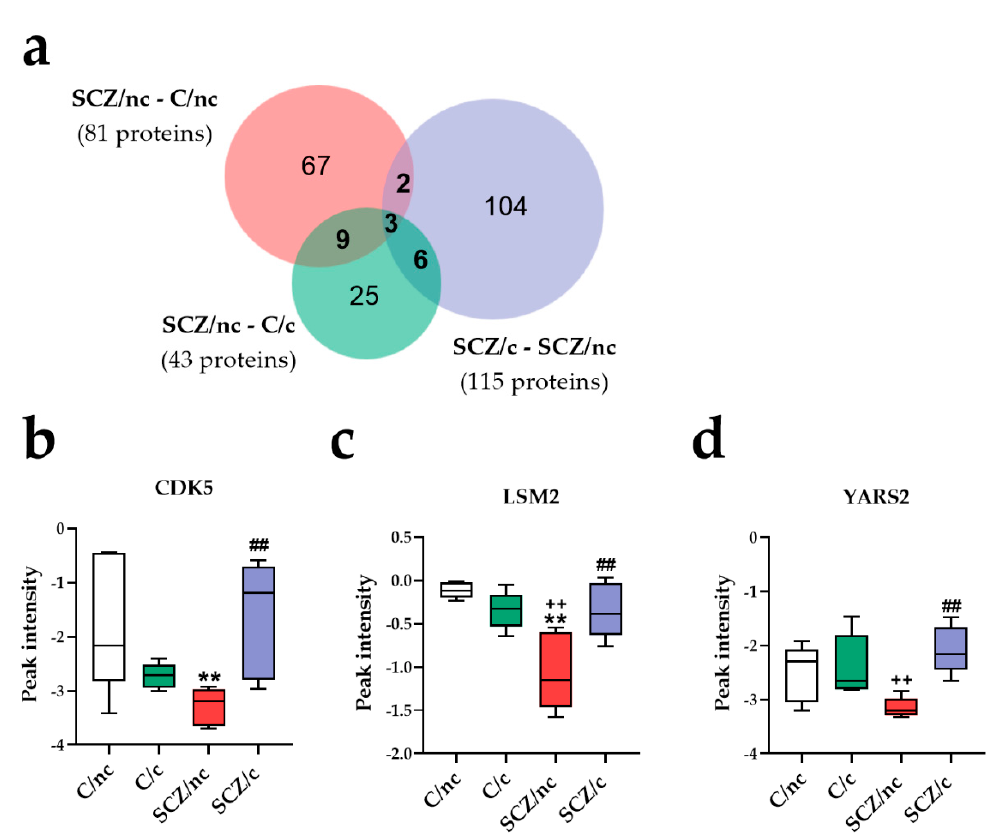
Figure 2. Specific proteomic markers of schizophrenia patients non-cannabis users (SCZ/nc). ( a ) Venn diagram comparing SCZ/nc to control subjects non-cannabis users (C/nc), control cannabis users (C/c) and schizophrenia patients cannabis users (SCZ/c). Graphical representation of CDK5 ( b ), LSM2 ( c ) and YARS2 ( d ), which were commonly deregulated in SCZ/c as compared to C/nc, C/c and SCZ/nc. ** p < 0.01; versus C/nc; ++ p < 0.01 versus C/c; ## p < 0.01 versus SCZ/nc.